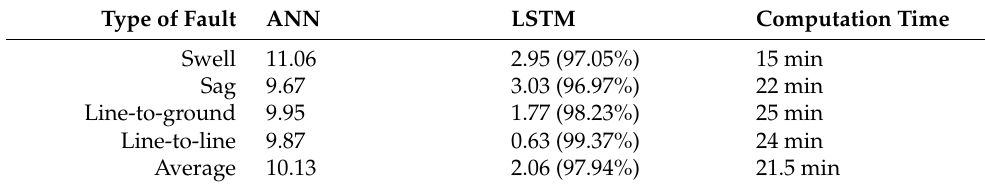
Table 5. MAPE values for different fault